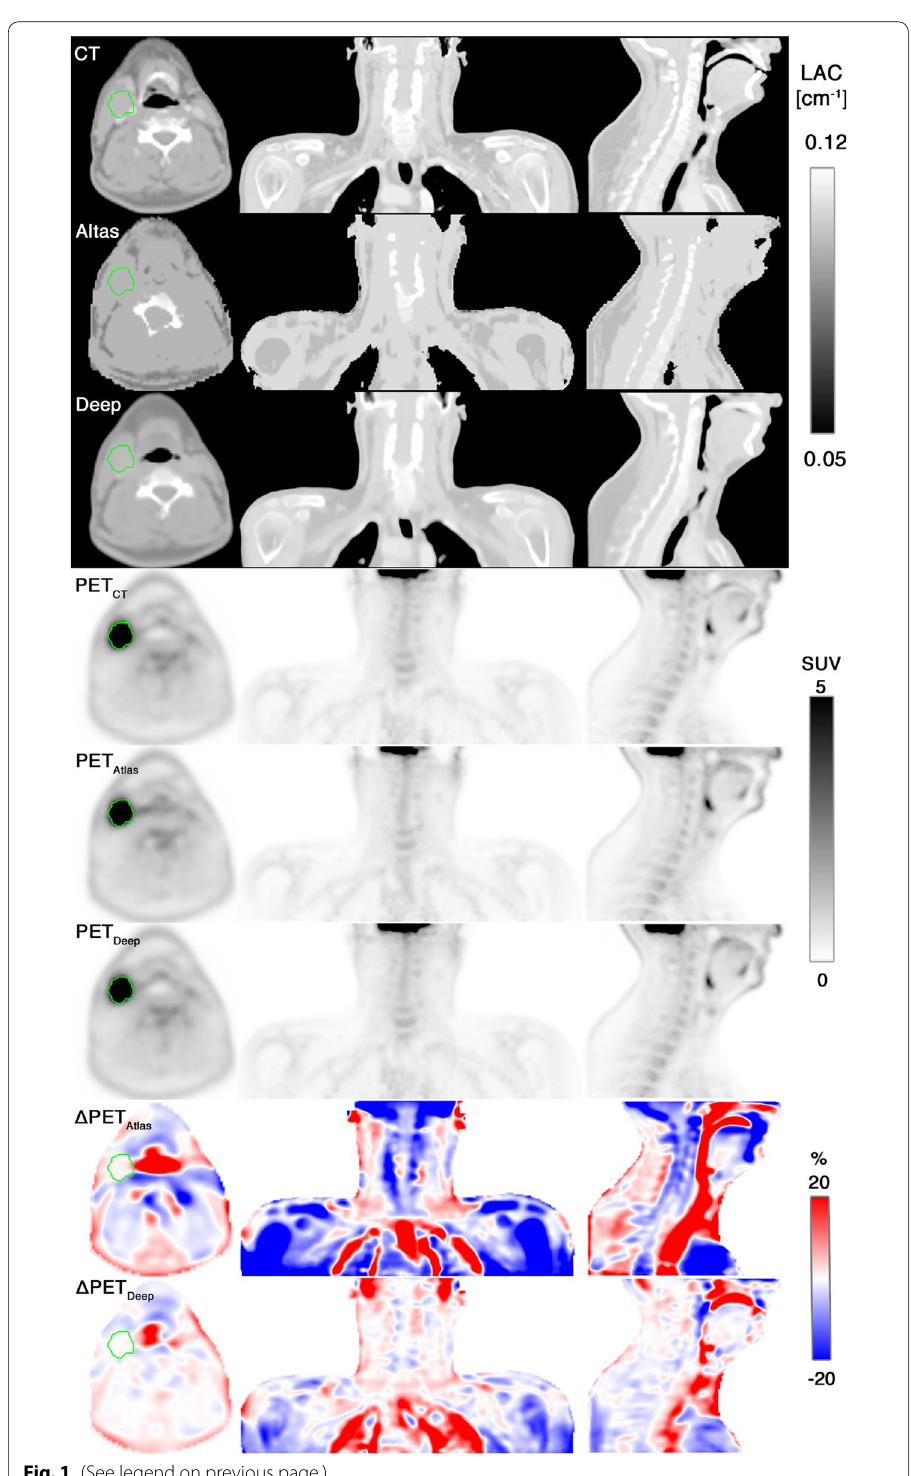
Fig. 1 (See legend on previous